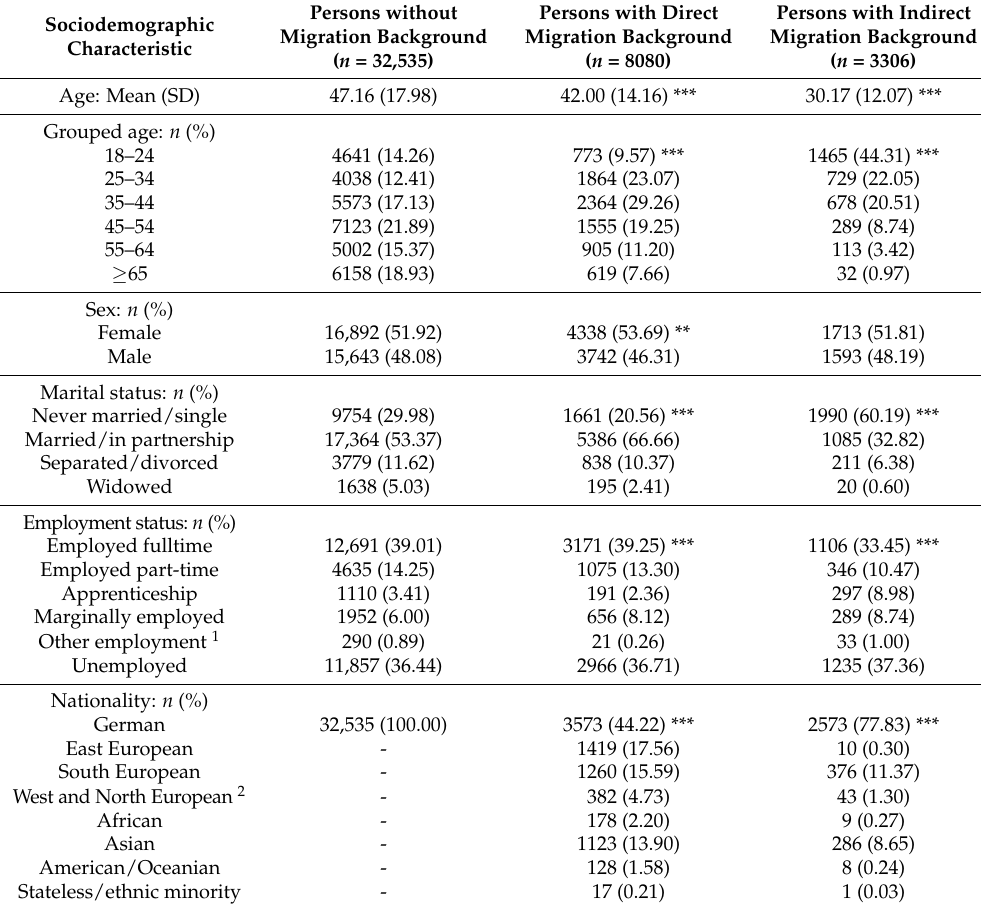
Table 1. Sociodemographic characteristics (years 2013 to 2019, n =